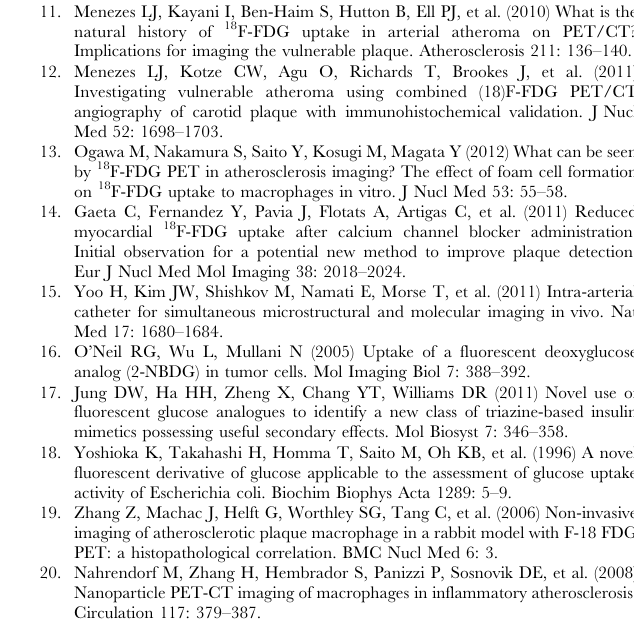
Figure S1 Fluorescence imaging of 6-NBDG uptake by macrophages. (a) In vitro fluorescence imaging of RAW264.7 macrophage cells (10 5 cells per well) with various concentrations of 6-NBDG fluorophore. (b) Significant positive correlation between the average radiant efficiency of all samples (n =6) with exposure time 0.5–10 seconds (any exposure over 10 seconds saturated the in vitro fluorescence image taken with IVIS-200) and 6-NBDG concentrations. A quadratic relationship between signal and concentration was found to be the best fit and highly significant (p , 0.0001 for all 3 exposure